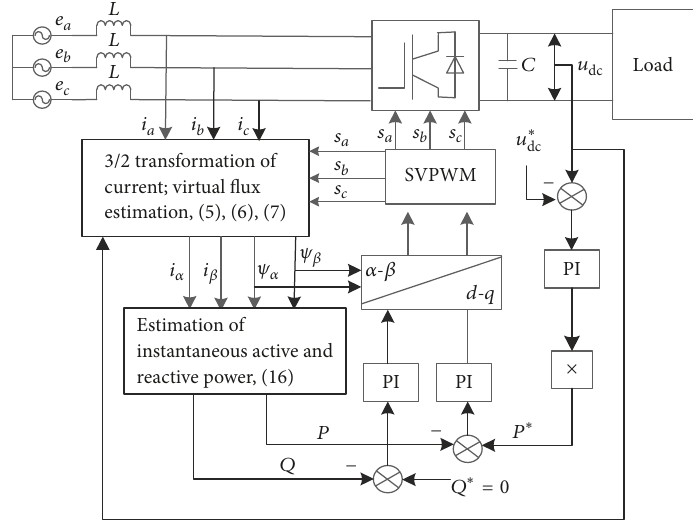
Figure 4: DPC system based on new virtual flux-linkage observer.